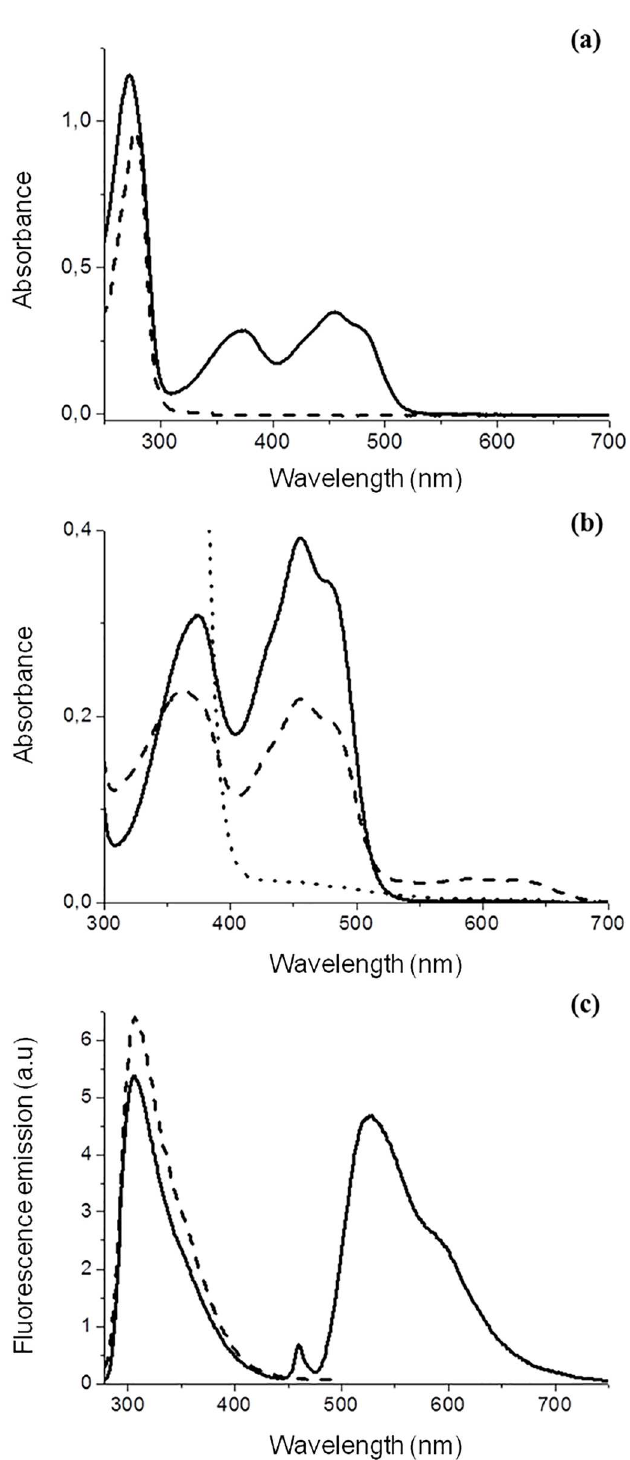
Fig 1. S . pneumoniae flavodoxin absorption and fluorescence spectra. (a) UV/VIS absorbance of 39 μ M holo (solid line) and 134 μ M apoflavodoxin (dashedline) in 150 mM NaCl, 100 mM MES, pH 6.5. (b) Spectra related to three redox states of 43 μ M Sp Fld in 150 mM NaCl, 100 mM MES, pH 6.5 at 10˚C: Oxidized (solid line), semiquinone (dashed line) with absorption maxima at 592 nm and reduced (dotted line). (c) Fluorescence emission spectra of 20 μ M Sp Fld holoprotein (solid line) and 20 μ M apoprotein (dashed line), in 150 mM NaCl, 100 mM MES, pH 6.5,